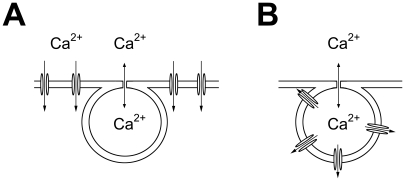
Possible pathways of FACE.(A) Ca2+ entry into the cytoplasm through channels located on the plasma membrane. (B) Ca2+ entry into the cytoplasm through channels located on the LB membrane. Here Ca2+ entry occurs in series with the fusion pore, with the consequence that the amount of Ca2+ entering the cytosol could be a function of fusion pore permeability, LB membrane permeability and amount of Ca2+ ions stored inside the LB. In both cases, A and B, channel activation may occur mechanically (membrane stress) or chemically (membrane merger; see also Discussion). The relative contribution of each model to FACE is yet unknown. In addition, intracellular amplification of the FACE-induced Ca2+ signal by Ca2+-induced Ca2+ release may take place.